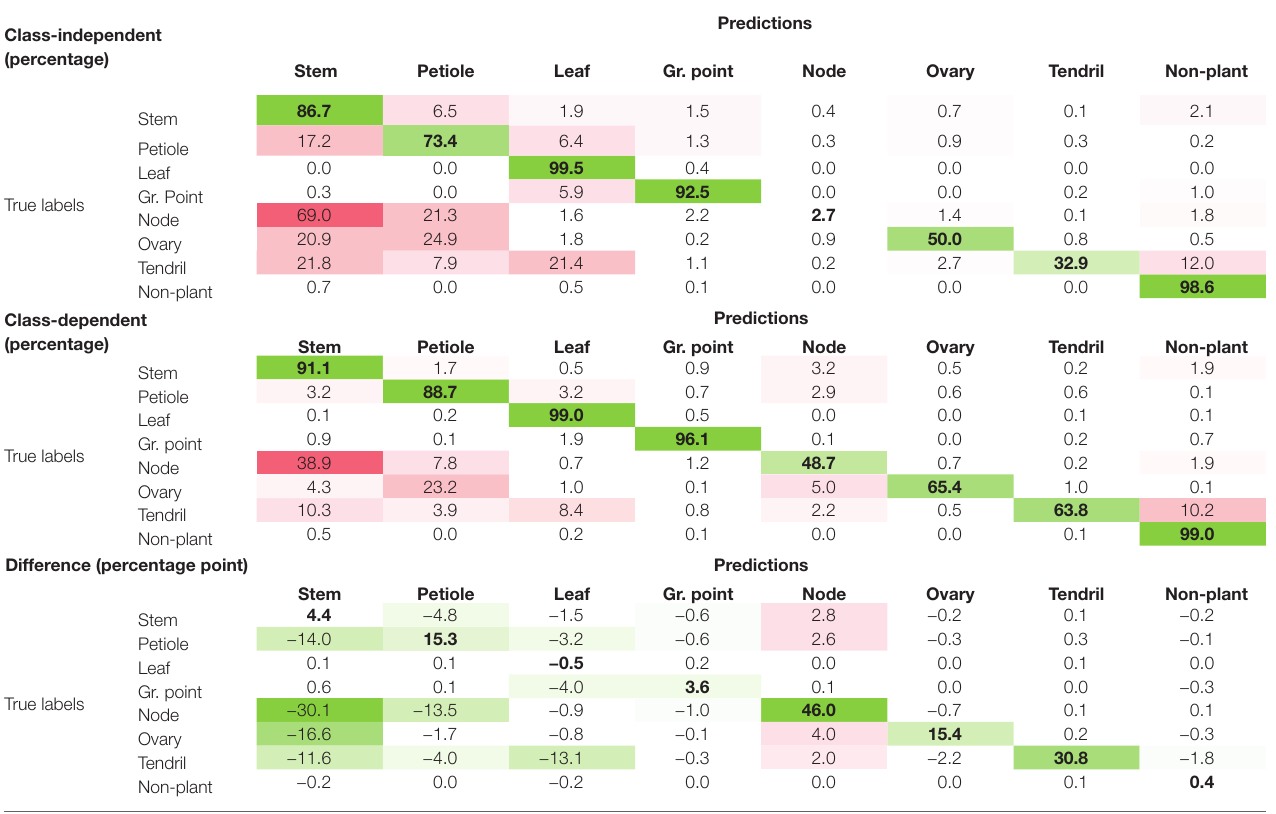
TABLE 1 | Confusion matrices for the trained network using the class-independent selection of anchor points, the class-dependent selection of anchor points and the difference between the two. Class-independent